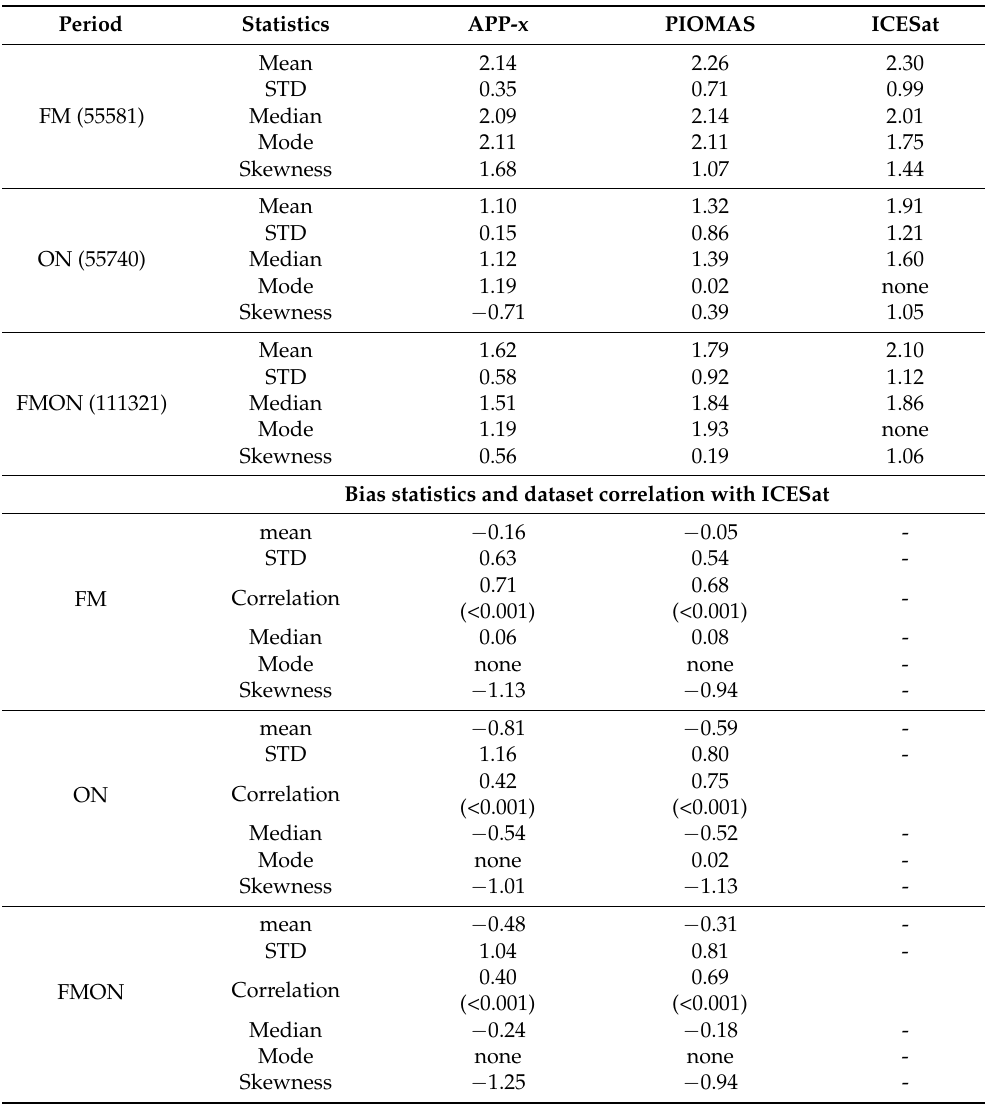
Table 2. Descriptive statistics for ice thickness in the three datasets (top half) and their differences and correlation with ICESat thickness (bottom half) in the three ICESat periods (meters). FM is February-March; ON is October-November; FMON is February, March, October, and November. The number in parentheses beneath the period name is the total number of pixels used for the comparison in that period. P-values are given in parentheses beneath the correlation